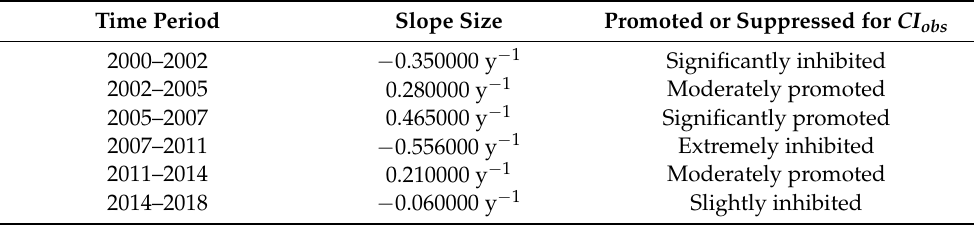
Table 6. Slope values of CI obs in different periods.